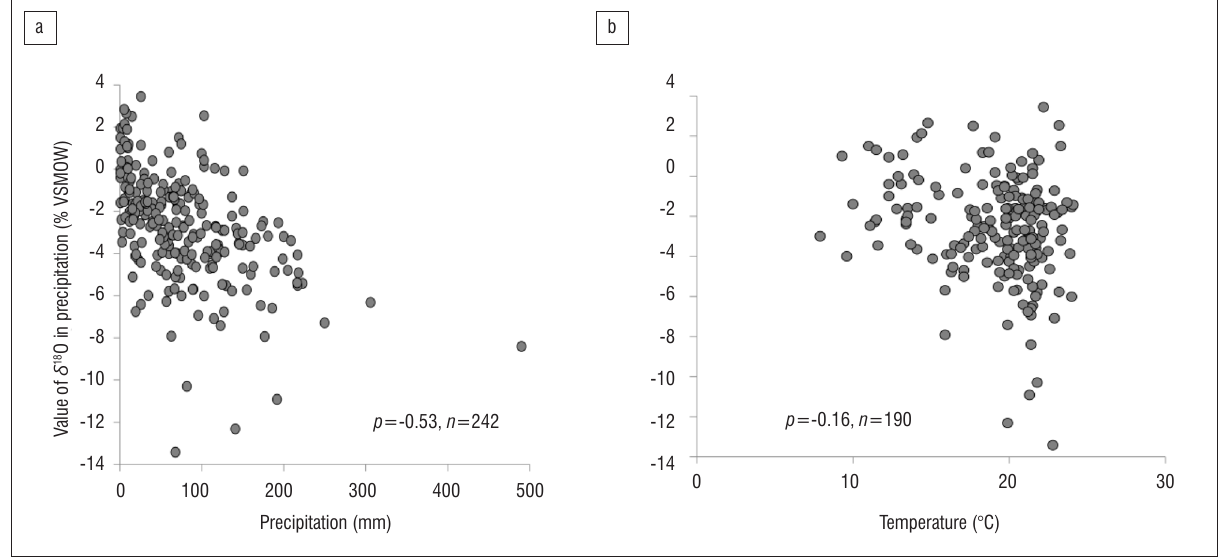
Figure 7: Oxygen isotopes in precipitation, measured for Pretoria. Monotonic relationship (Spearman’s rank correlation ρ ) between reported monthly δ 18 O values in precipitation and (a) total monthly precipitation, (b) average monthly temperatures. Both results were significant at the 95%